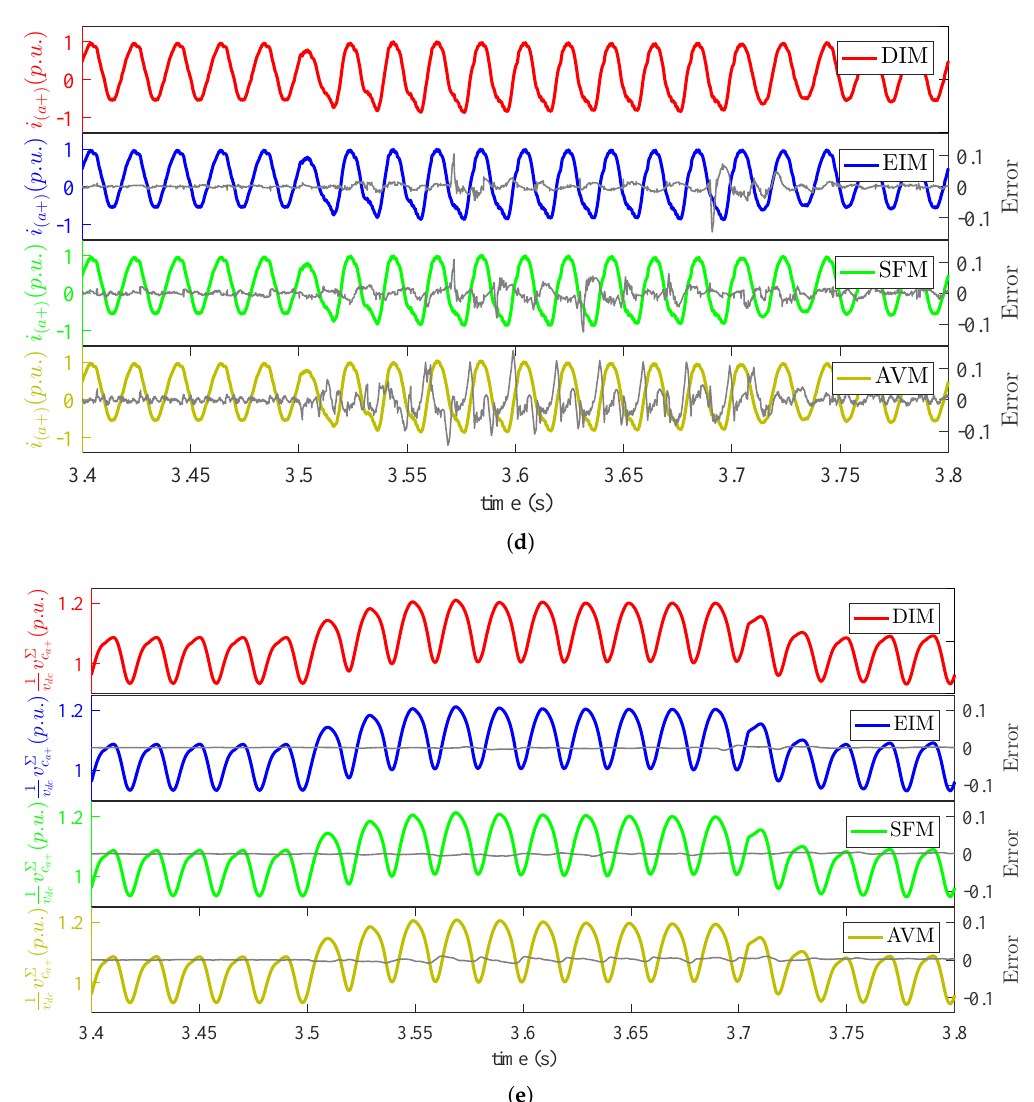
Figure 10. Single phase to ground fault. ( a ) AC voltage v ac the model error; ( c ) DC current i dc and the model error; ( d ) positive arm current i ( a +) and the model error; ( e ) cumulative capacitor voltage v